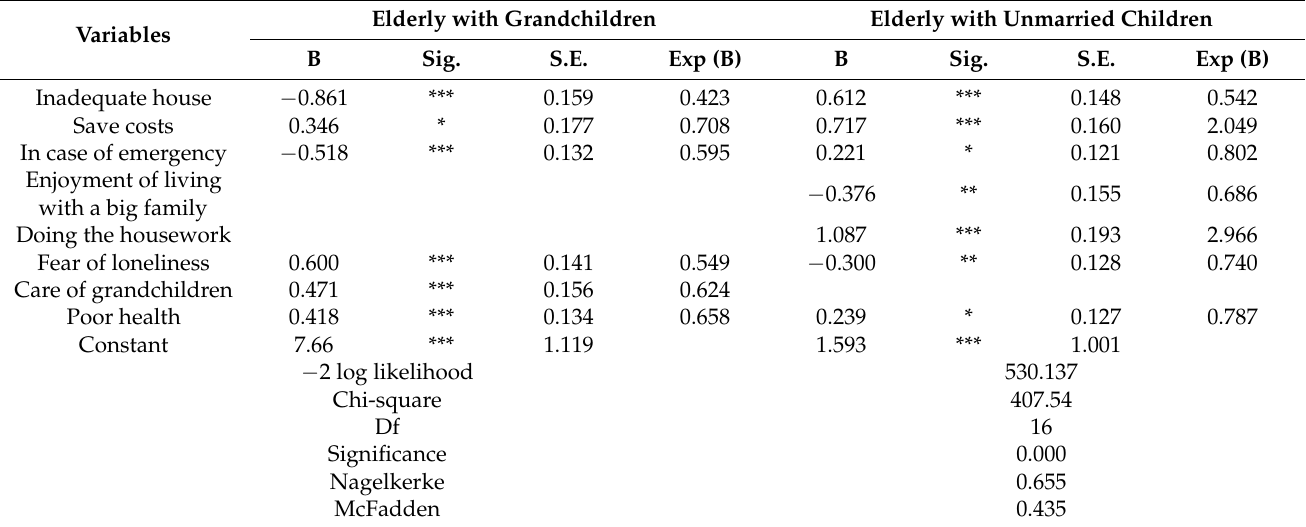
Table 5. Multiple logistic regression of intergenerational support in household cohabitation (N = 2465).